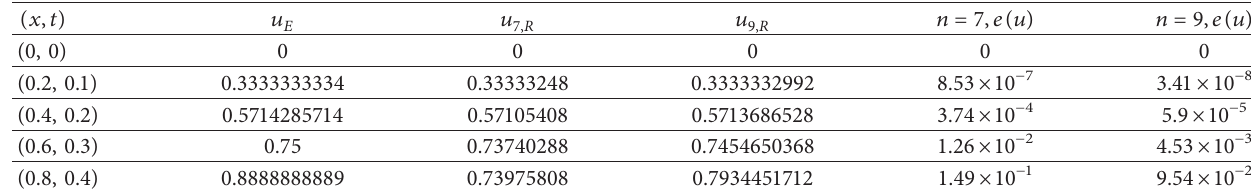
Table 4: Numerical result of Example 3.